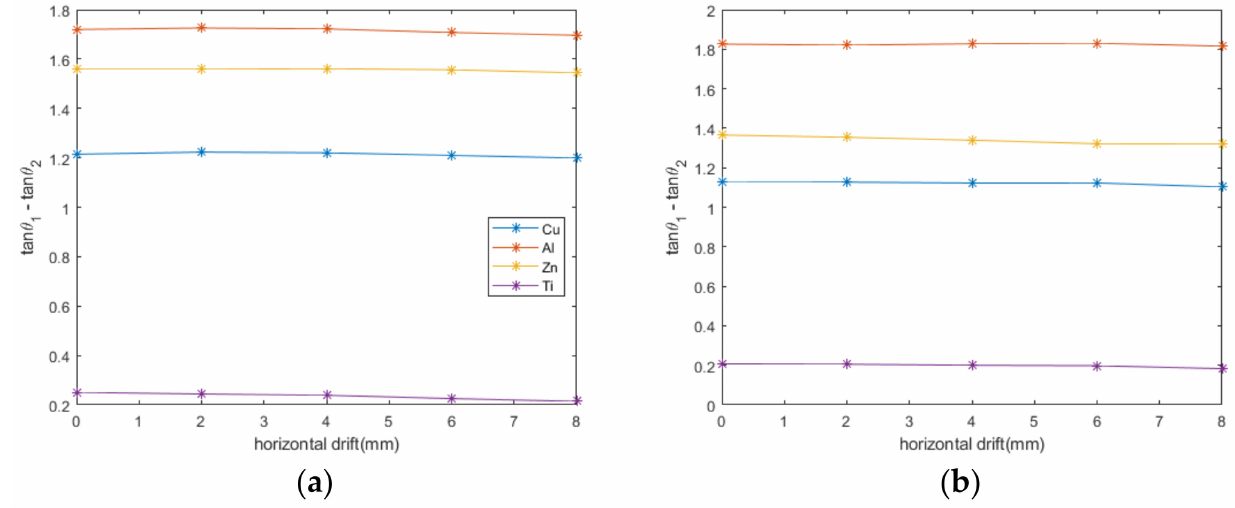
Figure 8. Effect of horizontal drift on the feature. ( a ) cylinder ( b )